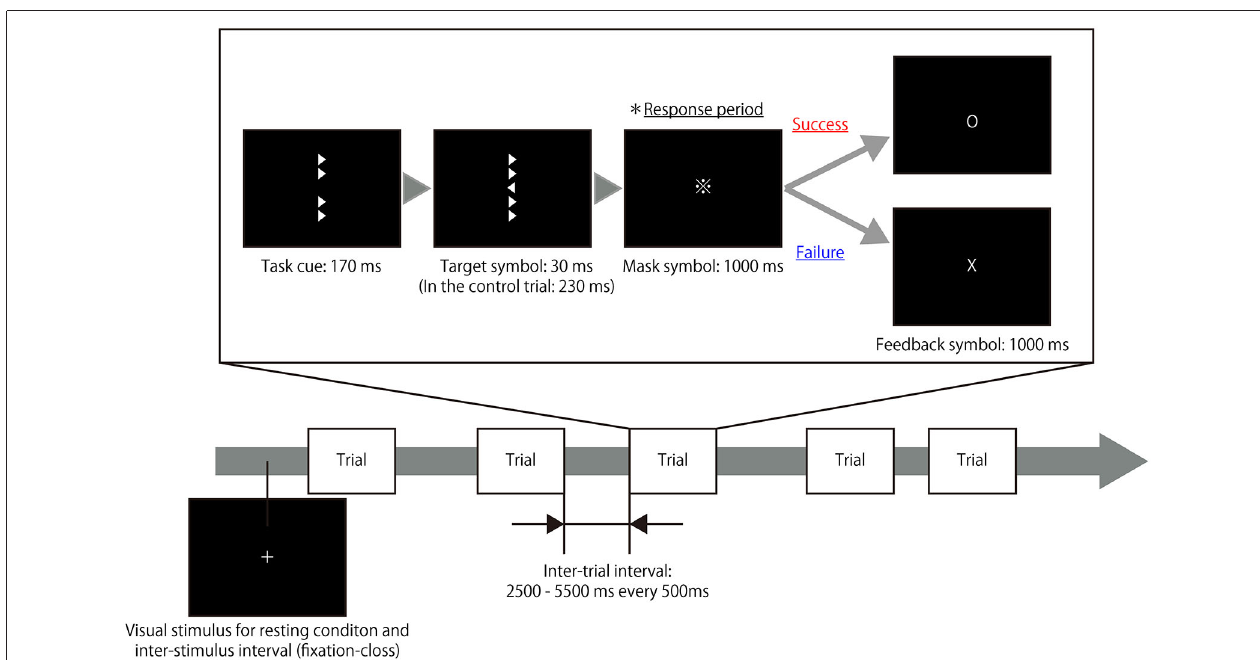
FIGURE 1 | Timeline of the experimental task. A target symbol with congruent or incongruent flankers was presented after a task cue that consisted of only flanker symbols. The presentation time of the target symbol during the task trials (30 ms) differed from the presentation time during the control trials (230 ms). The participants were instructed to judge the direction of the target symbol and respond by pressing a button during the response period in which a mask symbol was presented. Following the response period, a feedback symbol indicated the result of the trial. Thus, the participant was aware of whether his/her response was correct or not in each trial. During the resting periods and inter-trial intervals, a fixation cross was presented at the center of